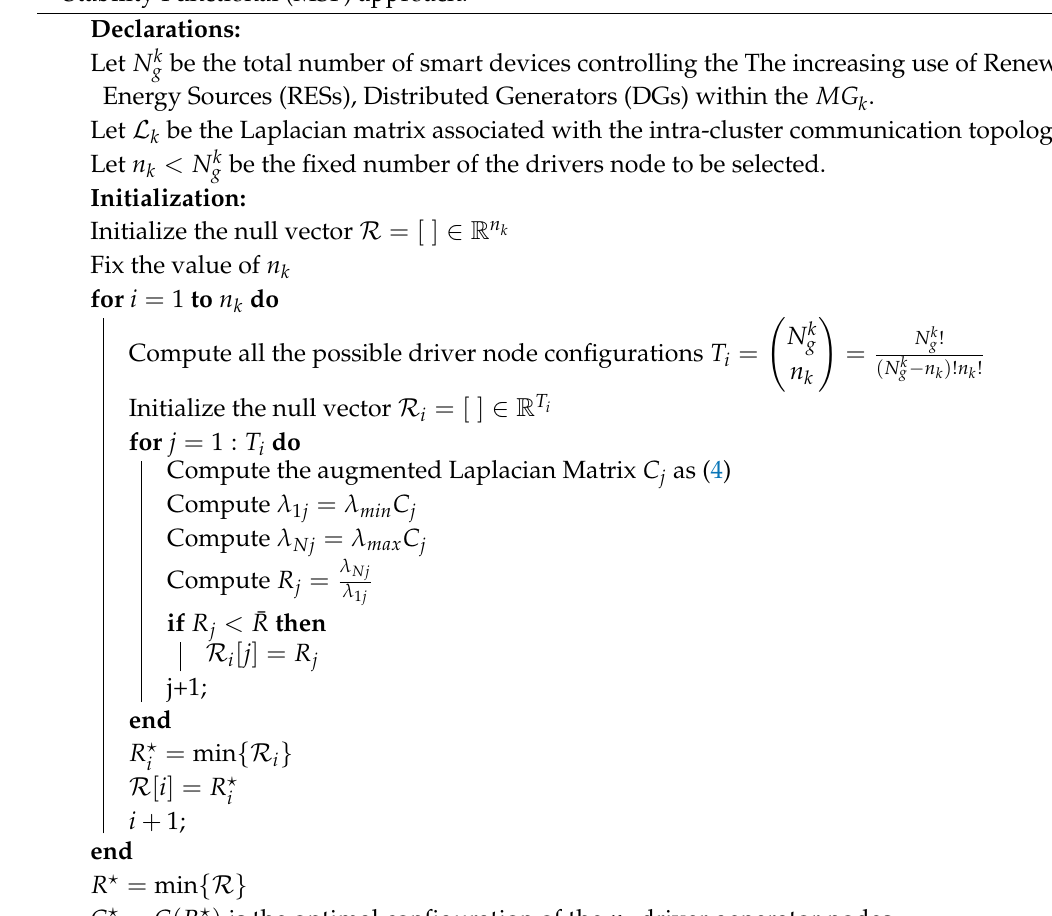
Algorithm 1: Selection of Driver Generator Nodes for the k -th MG ∀ k ∈ I M based on the Master Stability Functional (MSF)